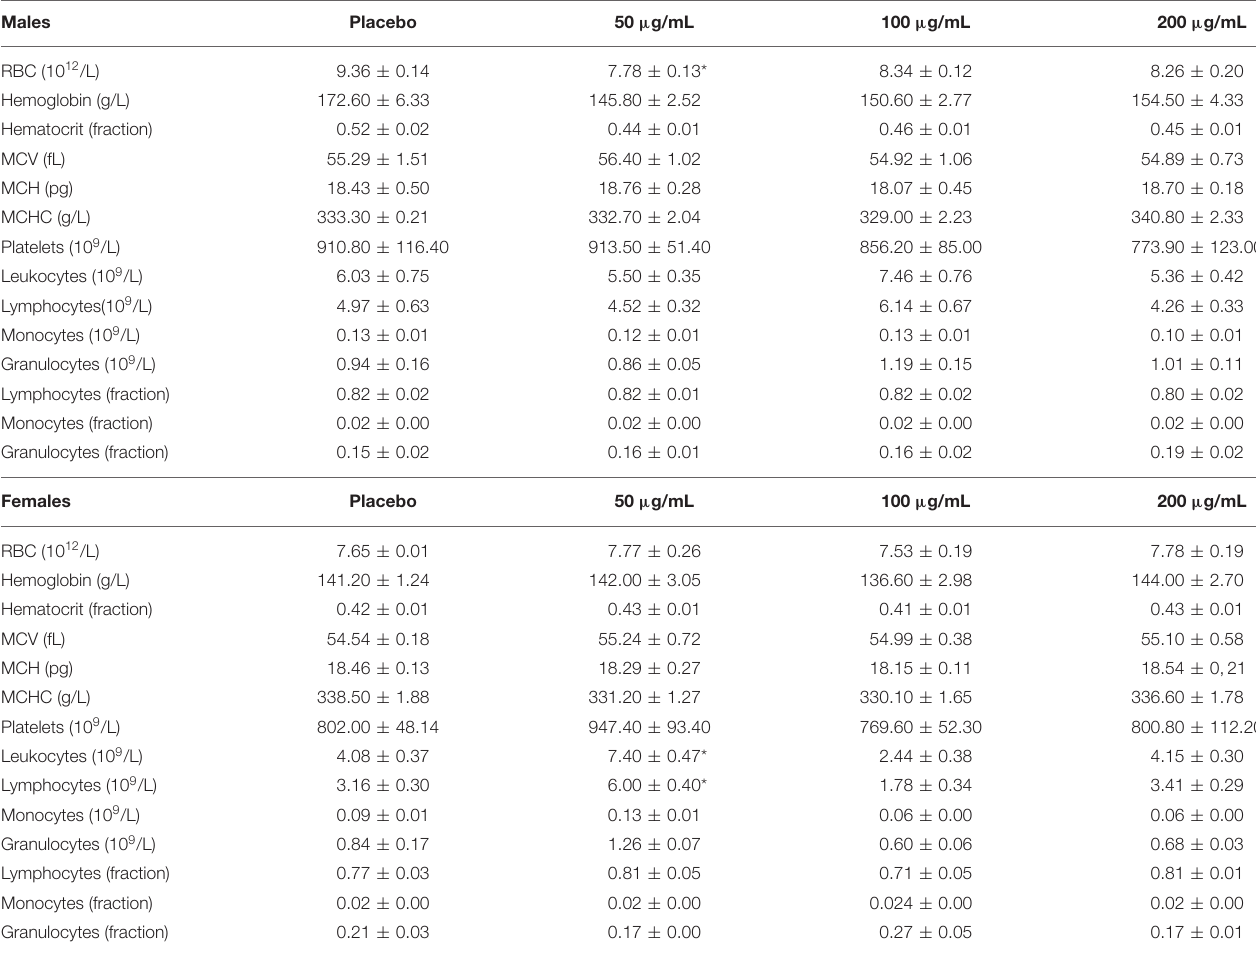
TABLE 1 | Hematology data from Wistar rats vaccinated with StreptInCor at different doses (50, 100 or 200 µ g/mL) compared with placebo.